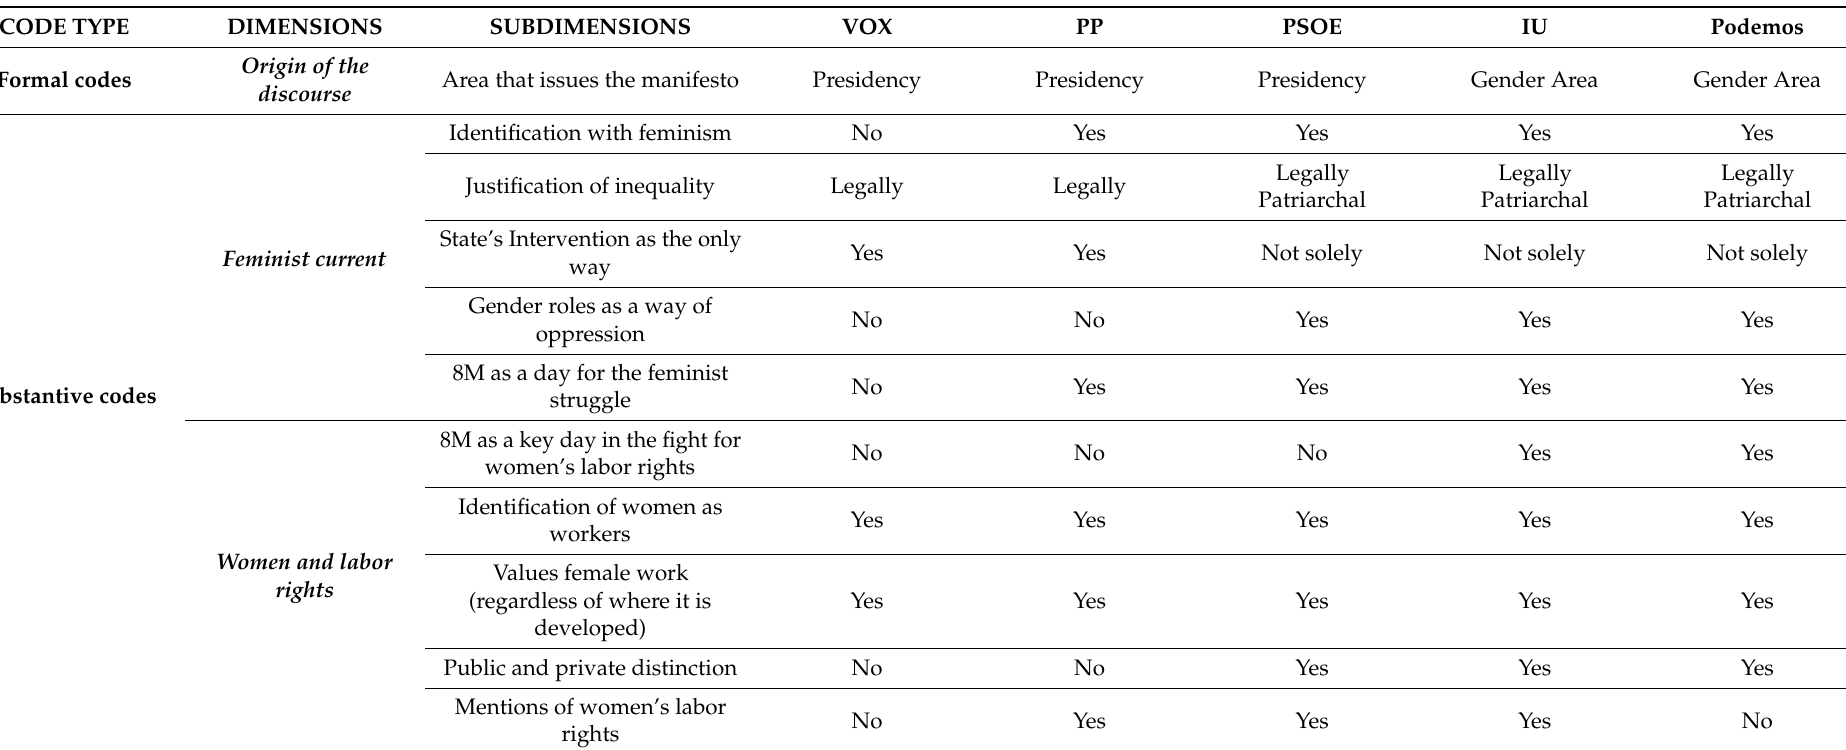
Table 1. Application of the codification protocol to the 8M manifestos by political party: the authors’ own elaboration from 8M manifestos in each political party of 2020, and Humlebaek and Ruiz’s codification protocol (Humlebaek and Ruiz